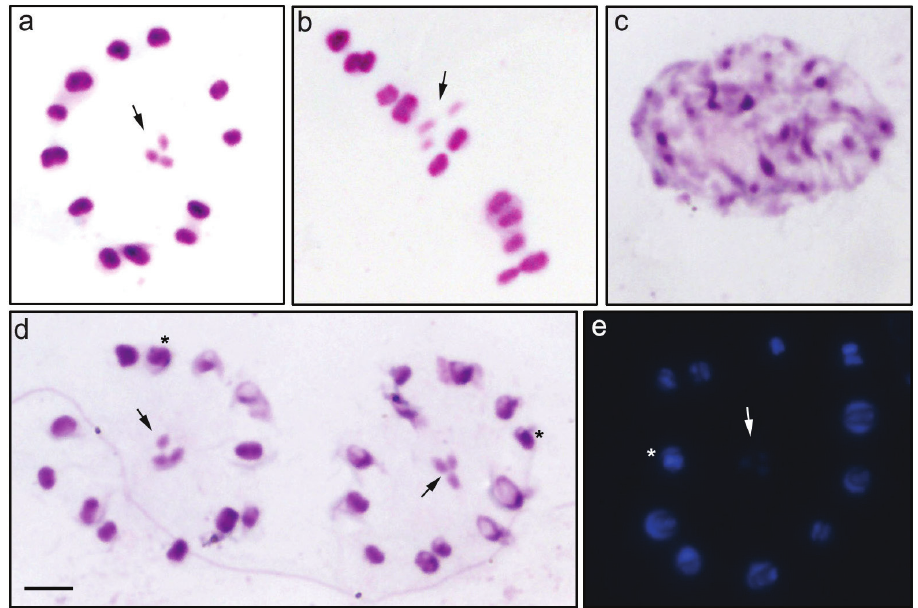
Figure 1. Meiocytes of Ricolla quadrispinosa. A, B conventional staining: metaphase II C conventional staining: interphase nucleus D Giemsa C-banding: metaphase II E DAPI staining: metaphase II. Sex chromosomes indicated by arrows. Interstitial heterochromatic block indicated by asterisk. Scale bar: